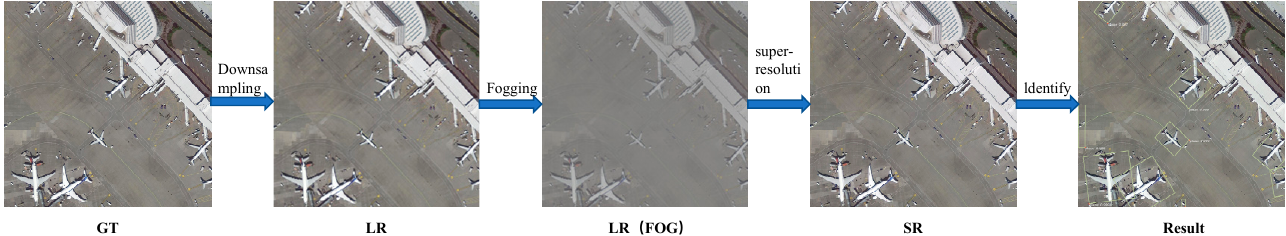
Figure 3. A flow chart of the remote sensing image recognition algorithm. Down-sampling the real high-definition image to obtain a low-resolution image, then simulating the fogging process on the low-resolution image to obtain a low-resolution foggy image, which is then super-resolution reconstructed, and finally the reconstructed image Target recognition on the image.